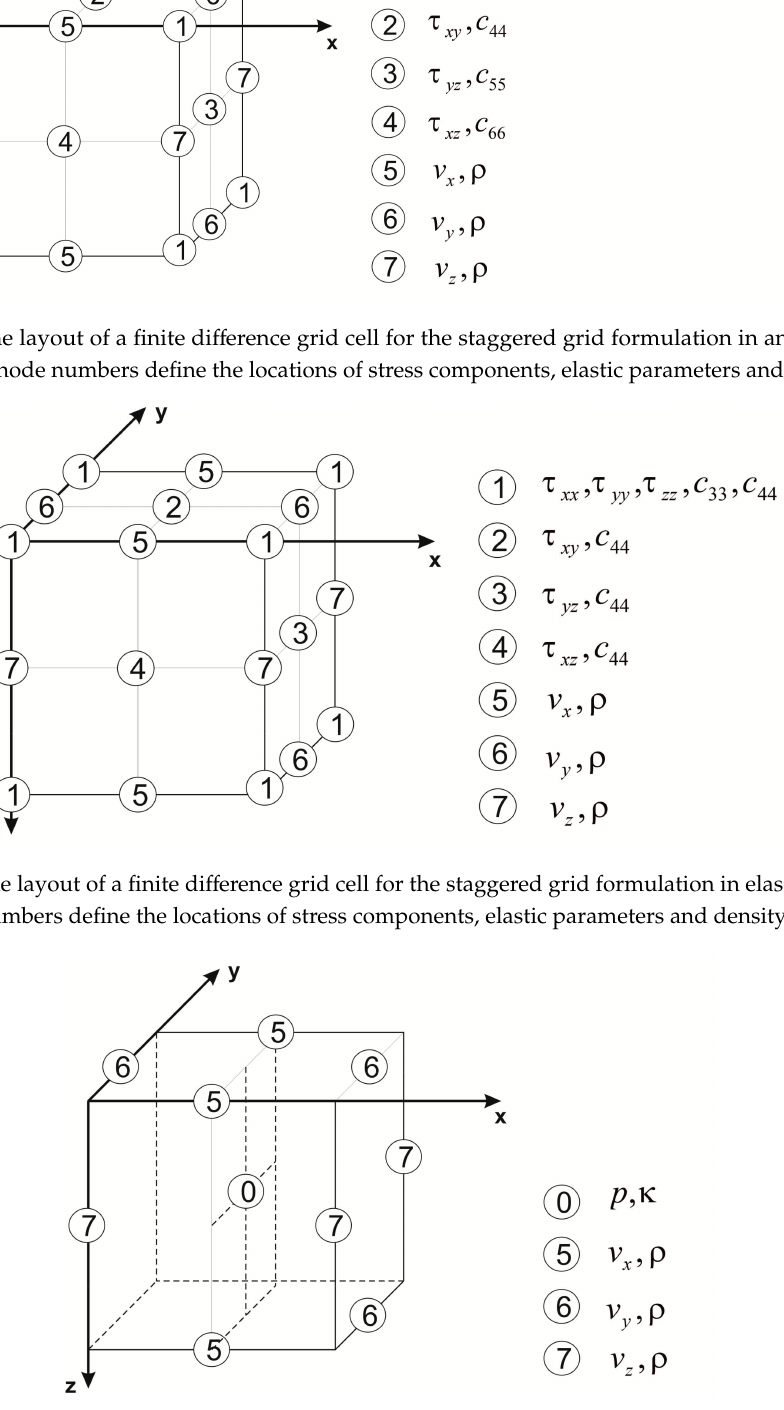
Figure 3. The layout of a finite di ff erence grid cell for the staggered grid formulation in acoustic media. The node numbers define the locations of stress components, elastic parameters and